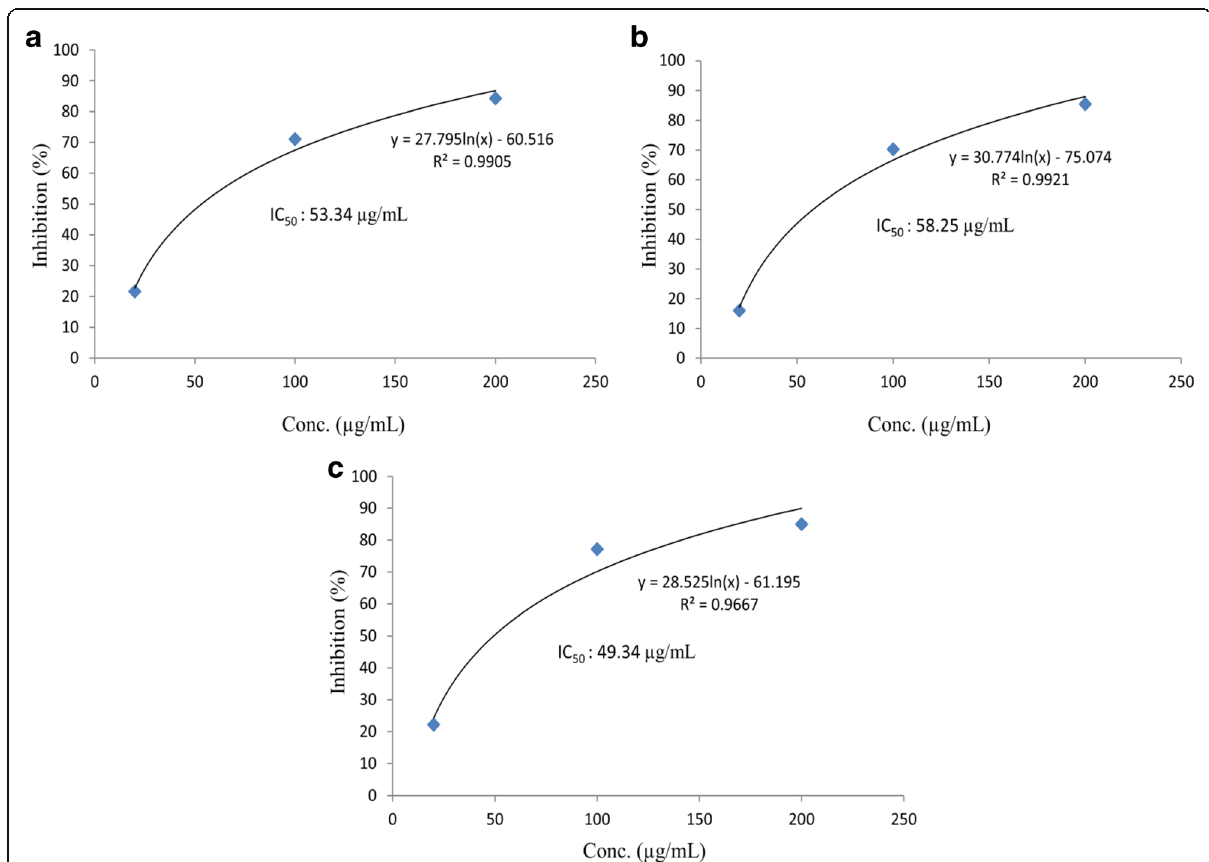
Fig. 1 The IC 50 value of MMMC at different ratio assessed using the DPPH scavenging assay. a 1:1 ( v /v) MMMC. b 1:3 (v/v) MMMC. c 3:1 (v/v) MMMC